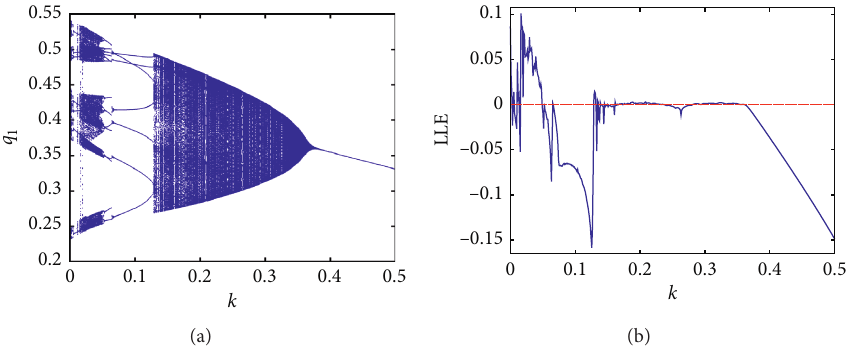
Figure 13: The bifurcation diagram and the corresponding LLE in terms of k